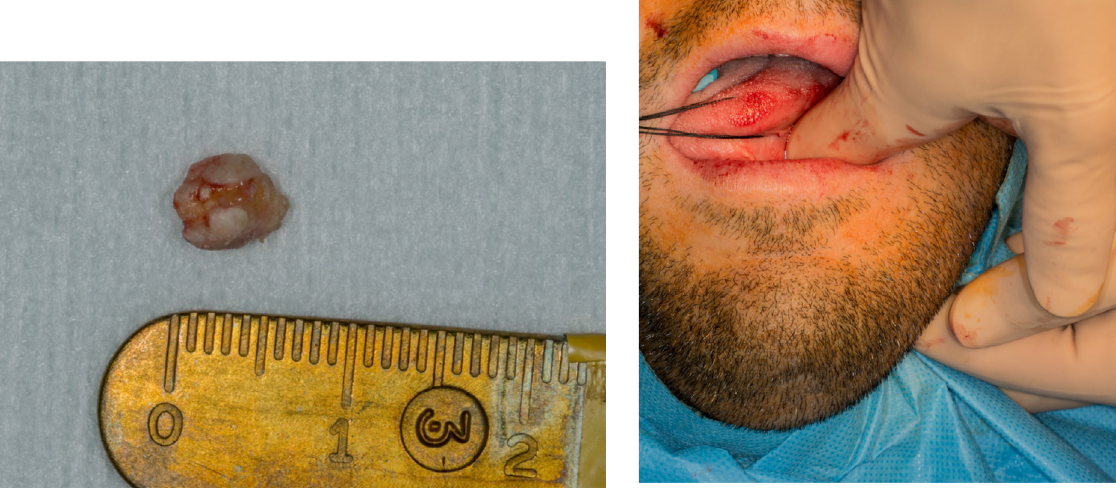
Fig. 4. Clinical view of an oval calculus.